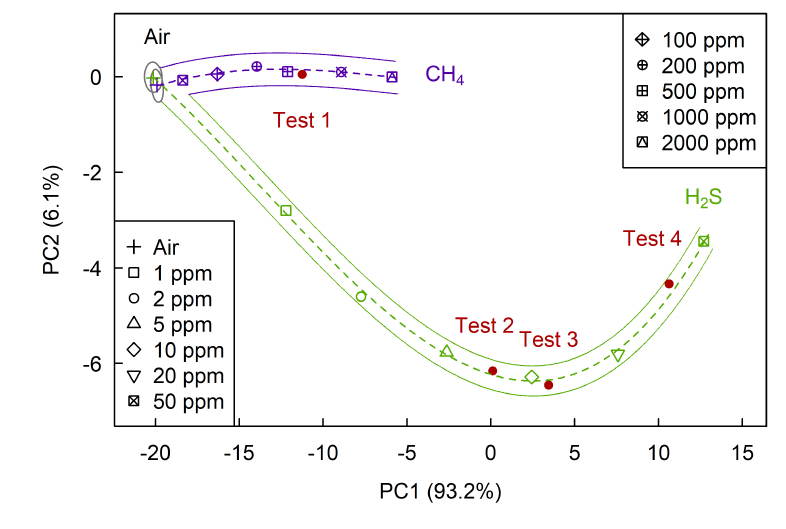
Figure 10. The (PC1, PC2) plane at the determination of H 2 S and CH 4